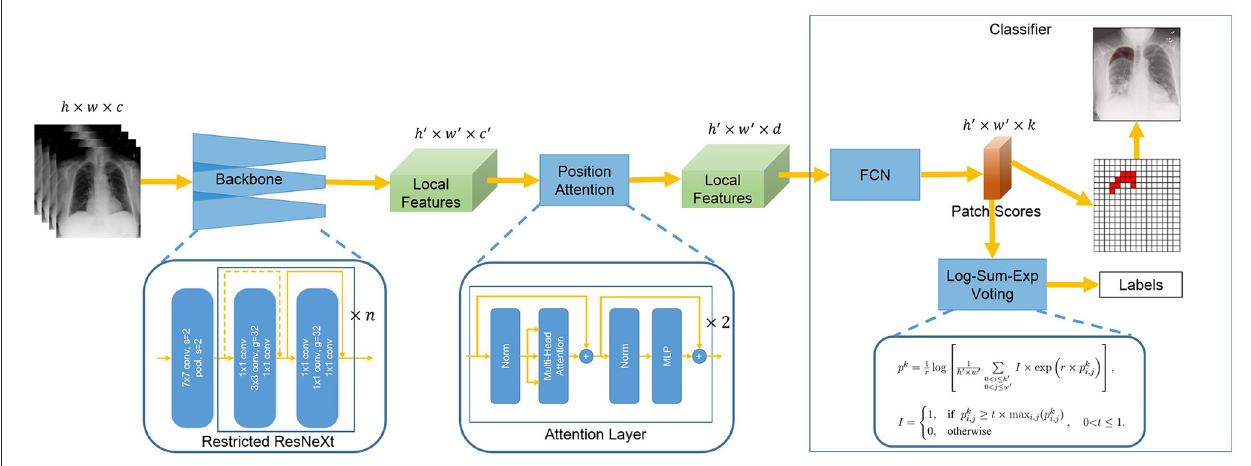
FIGURE 1 | Overview of Chest L-Transformer. A backbone with restricted receptive field CNNs is utilized to extract the local features. The position attention is added to Chest L-Transformer to highlight the features of the region of interest with positional embeddings. The local features are passed to a classifier for the prediction of the image labels as well as the lesion